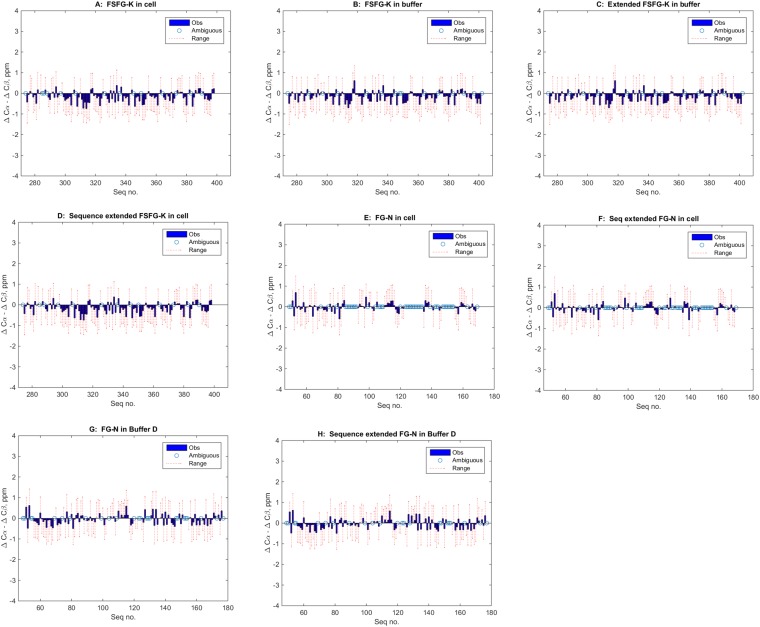
Lack of indicated secondary structure in FG Nup constructs (panels A–H, text).The most generally accepted indicator of propensity for secondary structure is the differences in deviations of 13C shifts of Cα and Cβ's (e.g., Spera and Bax, 1991; Wishart and Sykes, 1994; Wishart and Case, 2001, illustrated in e.g., Fushman et al., 1998; McDonnell et al., 1999; Mittag and Forman-Kay, 2007), with α-helical segments showing a value of ∼ +4, and β sheets a value of ∼ −4. However, the standard deviations of the underlying reference values have not been widely available until recently (Tamiola et al., 2010). In the above panels, the observed values of the difference of deviations for each residues is shown in blue (-●) while the range of the calculated standard errors is shown in red ( -- ). Values which are ambiguous or missing because of overlaps are indicated by an open circle ( O ). Panels are (A) FSFG-K in cell; (B) FSFG-K in buffer A; (C) same as B but those ‘degenerate’ sequences otherwise unassigned, are duplicated at the additional positions; for example, in this case the sequence surrounding P397 was most similar to that of P282 (ATSKPAFSF and ATSKPALEH) and the P282 values are used at position P397 for the 13Cα and 13Cβ assignments; (D) assignments of B extended; (E) FG-N in cell; (F) sequence duplicated values of E; (G) FG-N in buffer D; (H) Sequence extended values of set G. The data presented indicate no significant runs of deviation of the Δδ shift value, and none exceeding the standard deviations of the measurements. All conclusions in the paper are based on specific assignment, or grouped assignments in the case of overlaps and extended assignment, and do not rely on specific assignment in ambiguous/overlapped cases. When in cell assignments were ambiguous, and in buffer assignments were consistent with in cell observation, the in buffer assignments for specific residues were used.